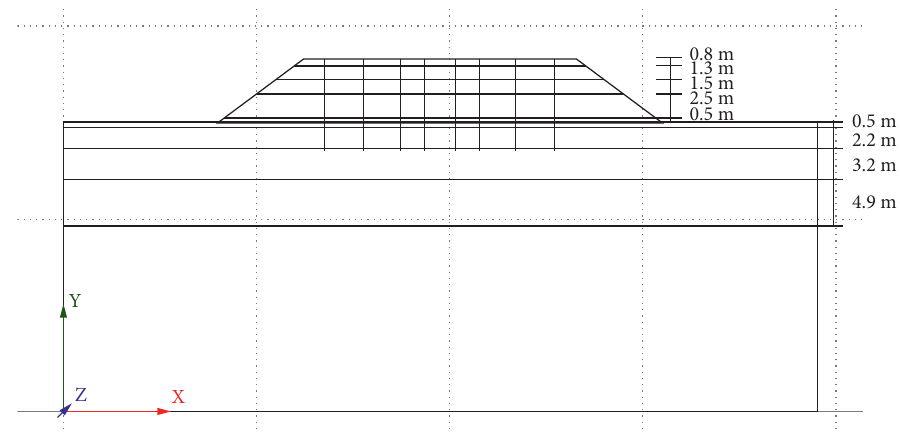
Figure 3: Schematic of the calculation model layers